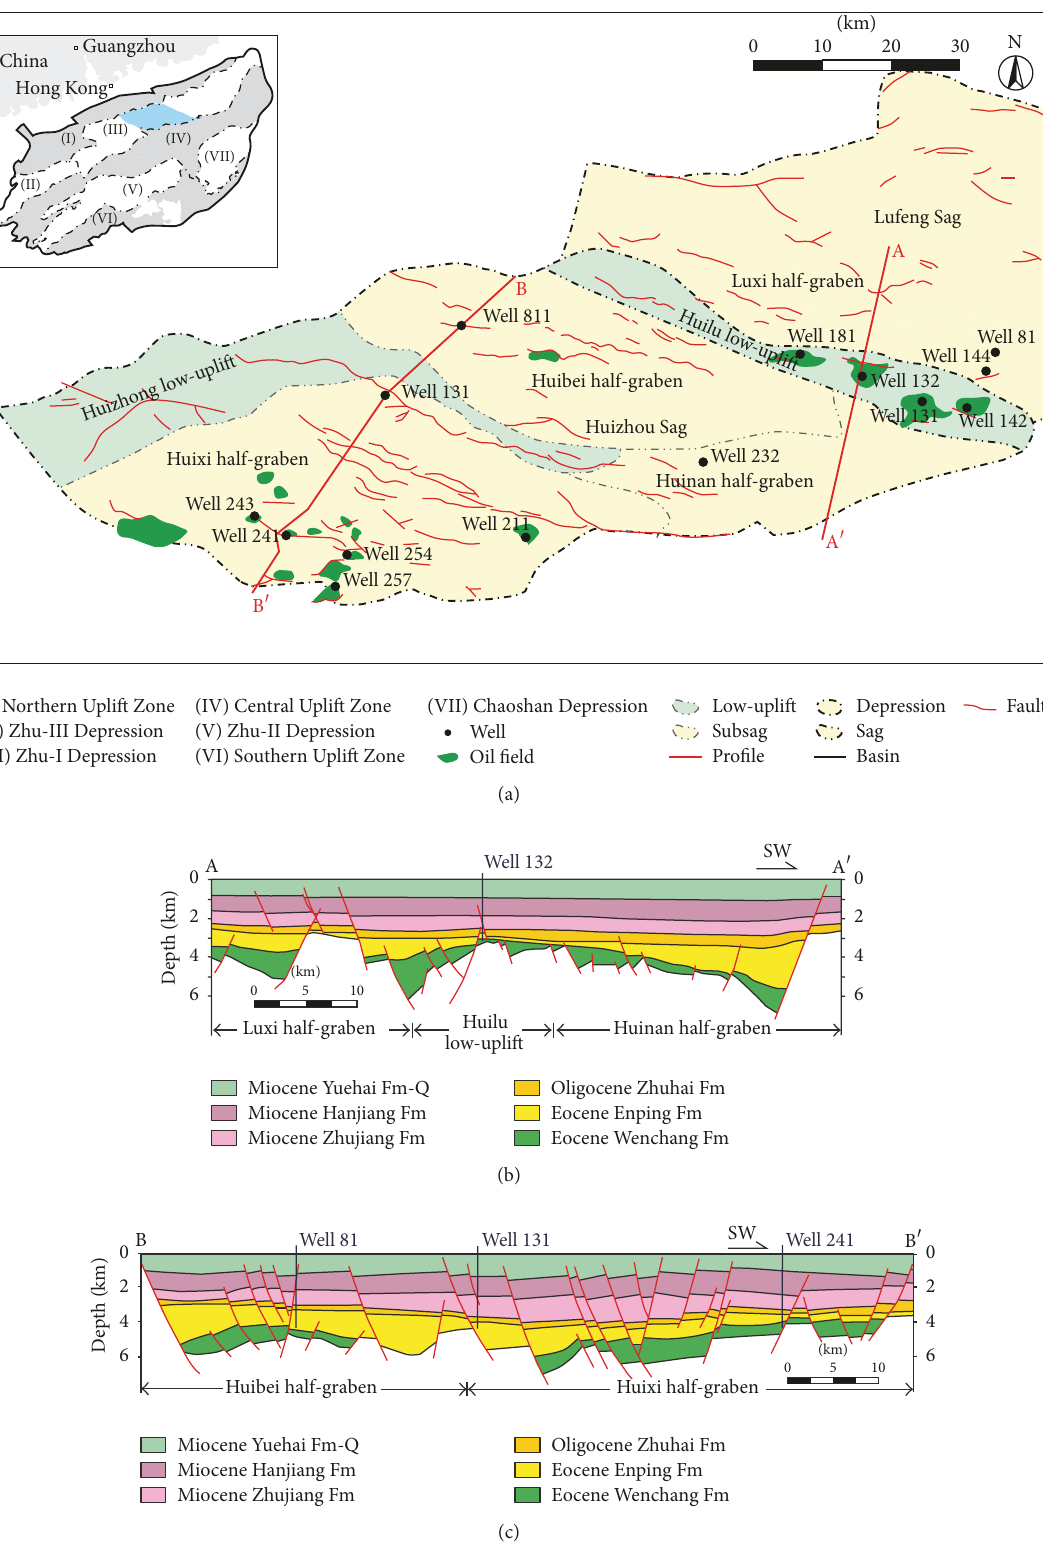
Figure 1: Regional location of the Huizhou Sag (a) and two geological profiles cross the Huilu low-uplift (b) and Huixi half-graben